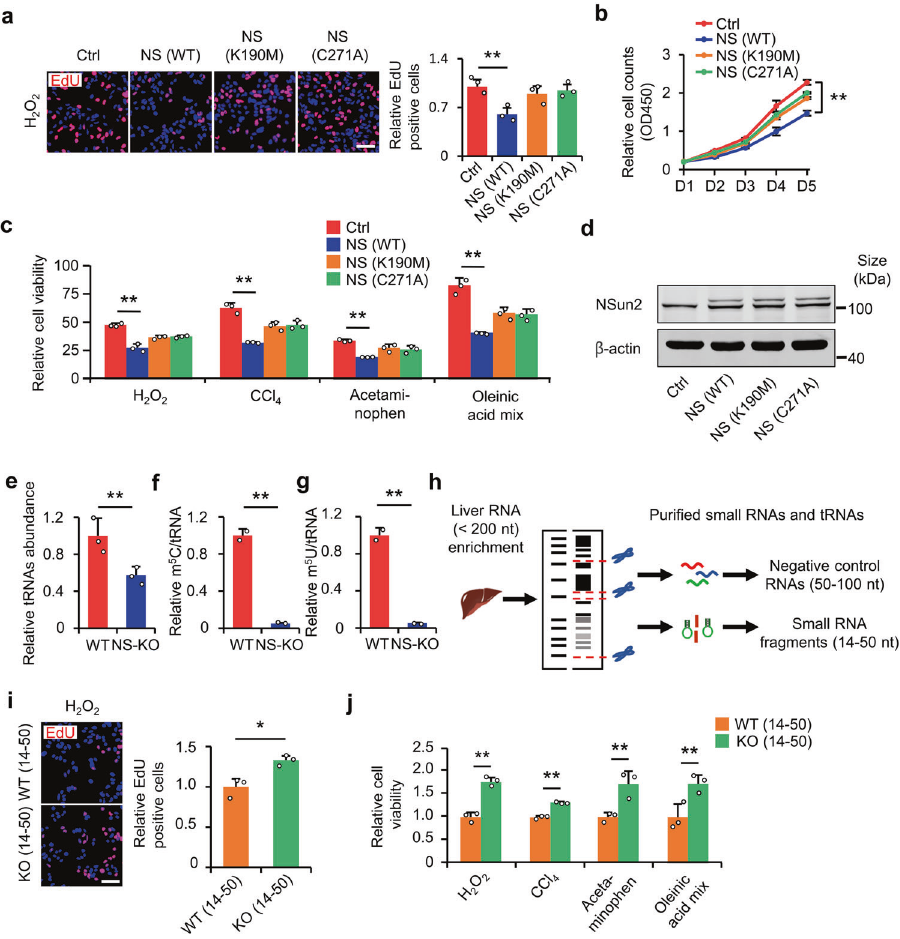
Fig. 3 NS-KO-derived tsRNAs alleviate liver injury. a NSun2 -knockdown HL-7702 cells were rescued with wild-type NSun2 (NS), two catalytically dead mutants (K190M, C271A), or the empty vector. Relative levels of EdU-positive cells were determined. n = 3 replicates. b Cell proliferation assay (CCK-8) of NSun2 -knockdown HL-7702 rescued by enzymatic-dead NSun2 . Detection of OD450 at the indicated times (day 1, day 2, day 3, day 4, day 5) under H 2 O 2 stress, ** P < 0.01, versus NS-KD at day 5. c Cell viability detection of NSun2 -knockdown HL-7702 rescued by enzymatic-dead NSun2 . Relative cell viability was assessed by CCK-8 assay. n = 3 replicates. The data in Fig. 3c and Fig. 1g are from the same batch of experiments. d NSun2 expression was measured to verify the rescue effect of NSun2 by western blotting in ( a – c ). e tRNA abundance in WT and NS-KO mice. Data indicate the tRNA abundance relative to WT, n = 3 mice. f , g Liquid chromatography-mass spectrometry showing the differences of tRNA m 5 U ( f ) and m 5 C ( g ) modi fi cations in WT and NS-KO mice. Data are shown as a relative value (tRNA modi fi cation/total tRNA), n = 2 mice. h Schematic for isolating small liver RNAs. i EdU assay showing the proliferation of isolated fragments. EdU-positive cells were analyzed as data relative to WT. Scale bar, 100 μ m. n = 3 replicates. j CCK-8 assay showing the survival of isolated fragments. Relative